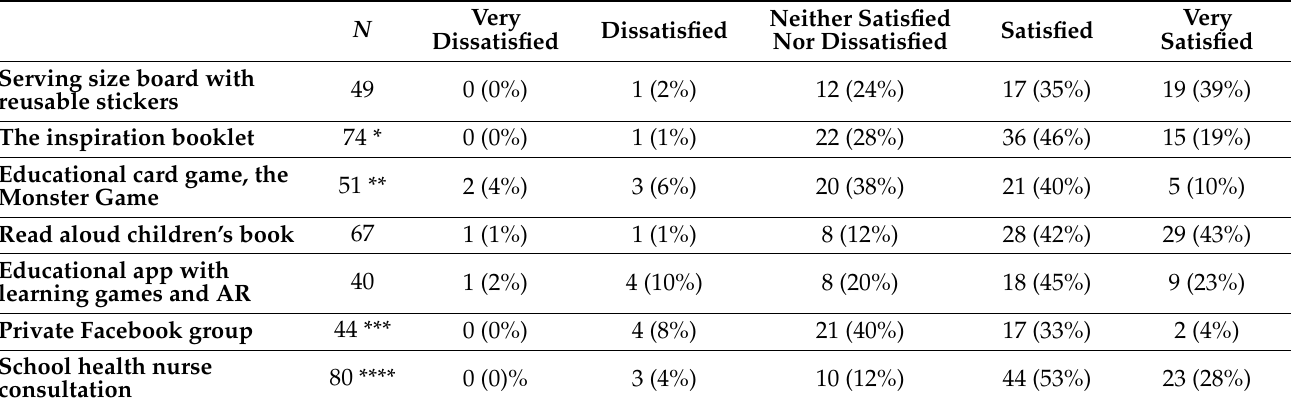
Table 3. Ratings of materials among users